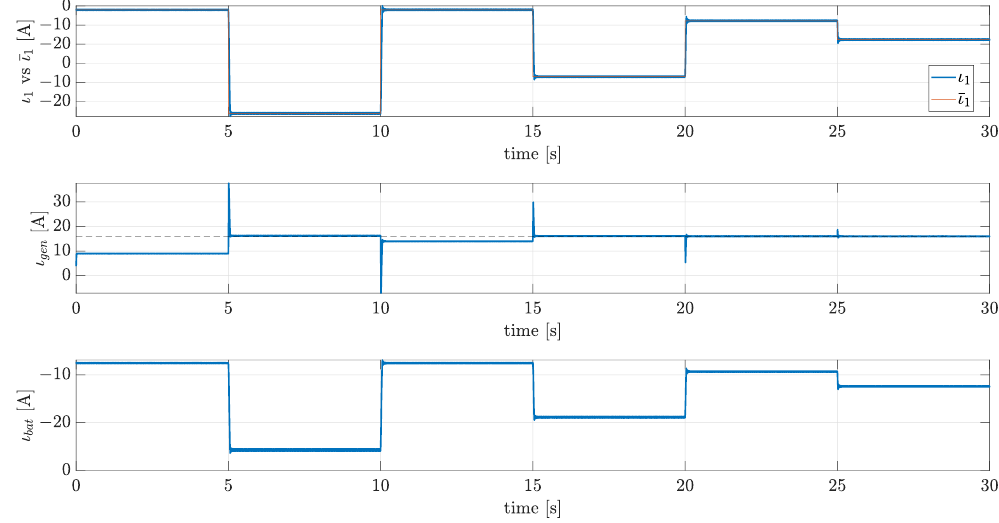
Figure 5. Boost mode. From top to bottom: converter input current ι 1 ( blue solid line ) and current reference ¯ ι 1 ( red solid line ); generator current ι gen ( blue solid line ) and its threshold value ( black dashed line ); battery current ι batt ( blue solid line ).